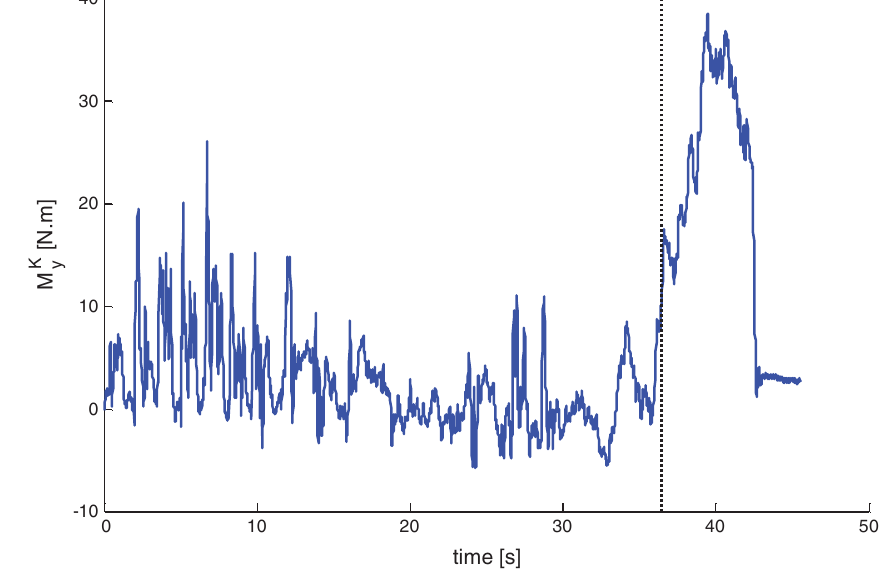
Fig. 9. Knee moment (vertical lines indicate the instant of knee